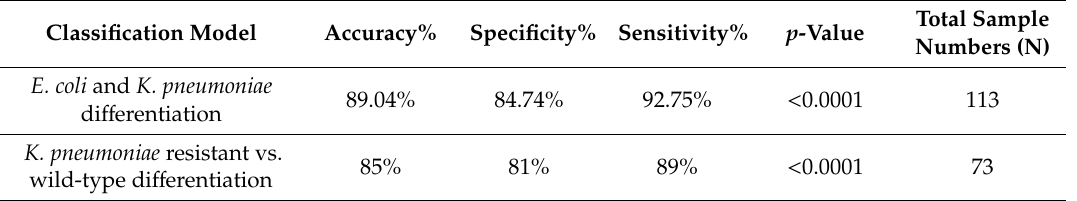
Table 2. Results summary for accuracy, specificity and sensitivity for each of study analysis.